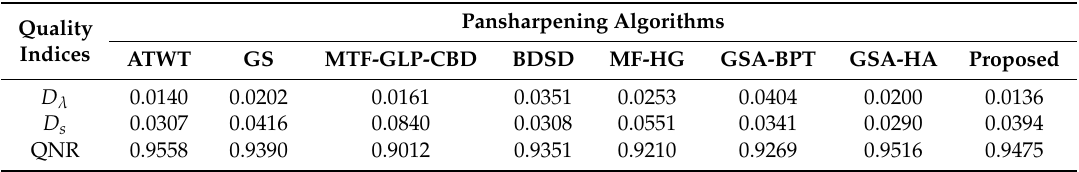
Table 4. Objective quantitative indices obtained by compared methods for real GeoEye-1 data set.